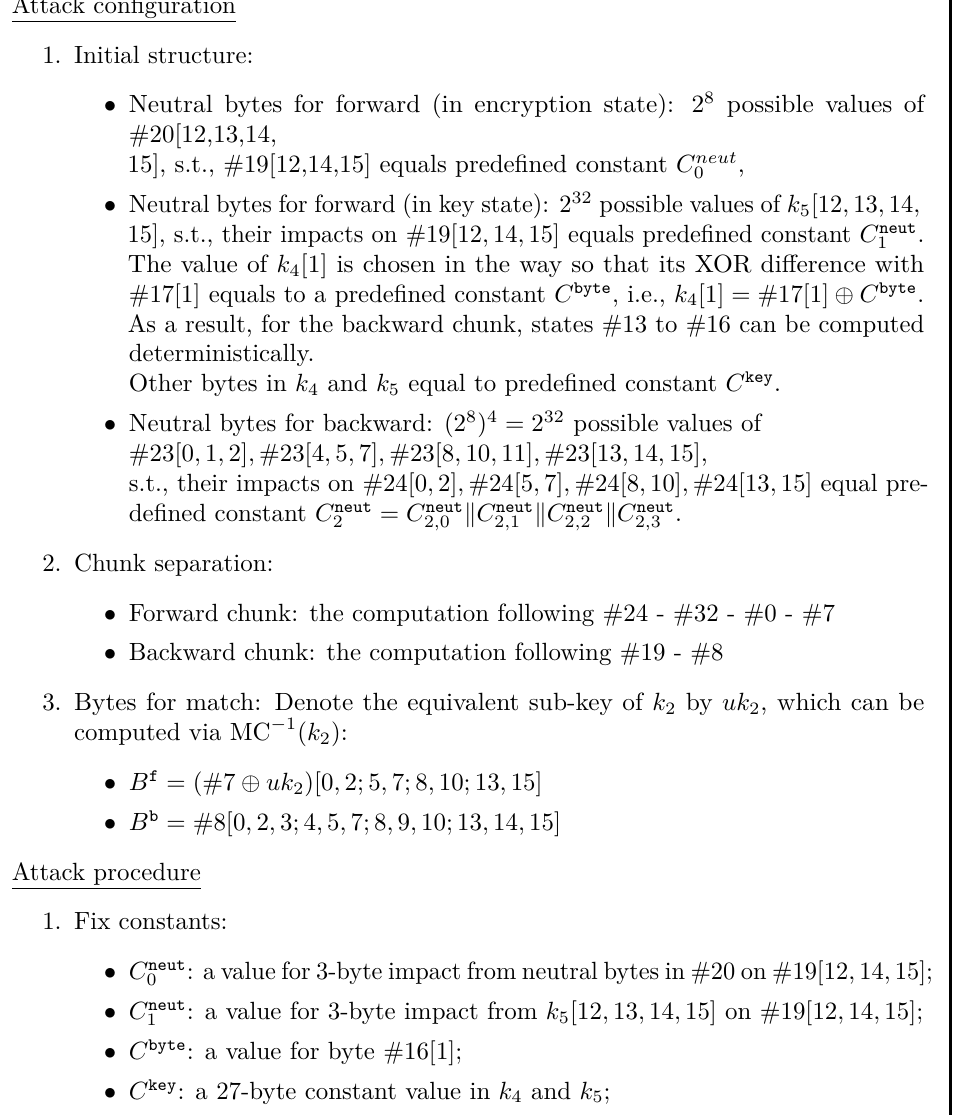
Attack 2: The pseudo-preimage attack on 8-round AES -256 hashing mode Attack